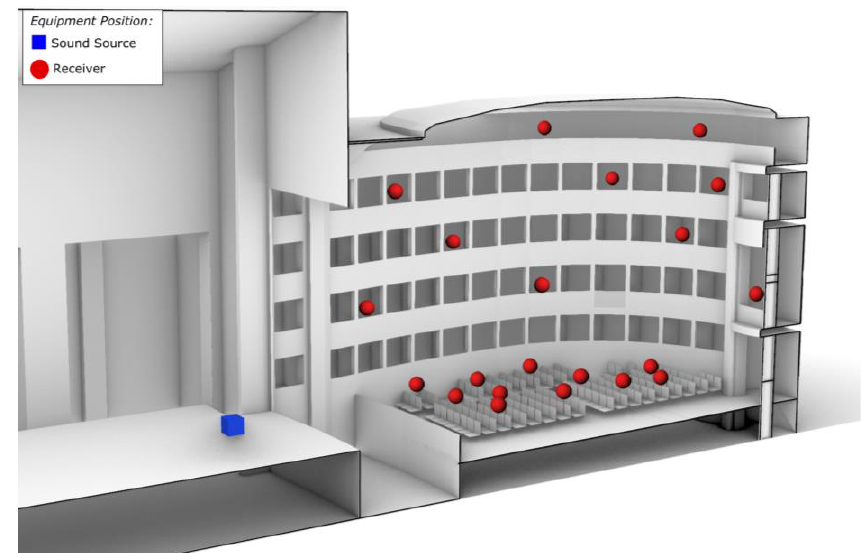
Figure 4. Scheme of the equipment location during the acoustic survey.